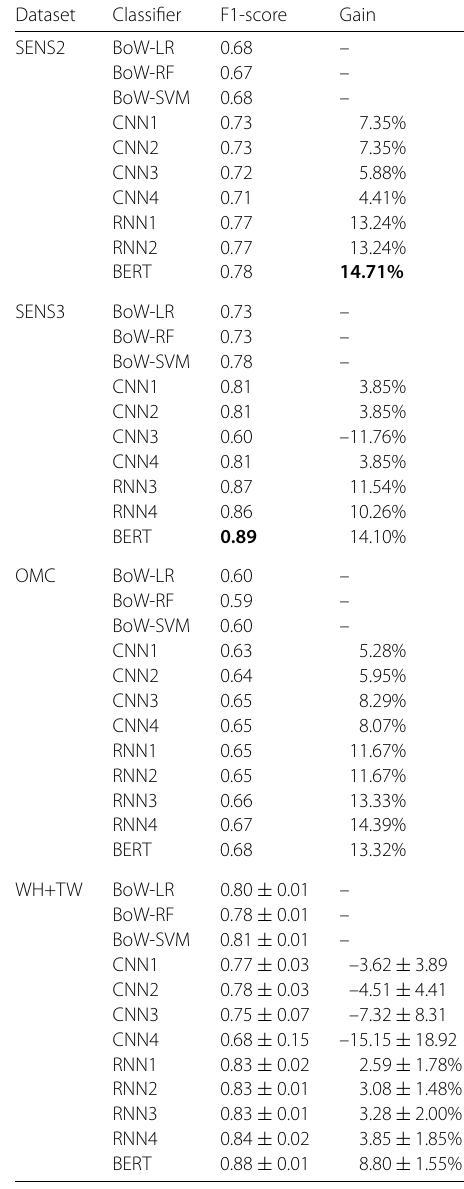
Table 16 Classification results (macro-averaged F1-scores and percentage gain w.r.t the best bag-of-word classifier)